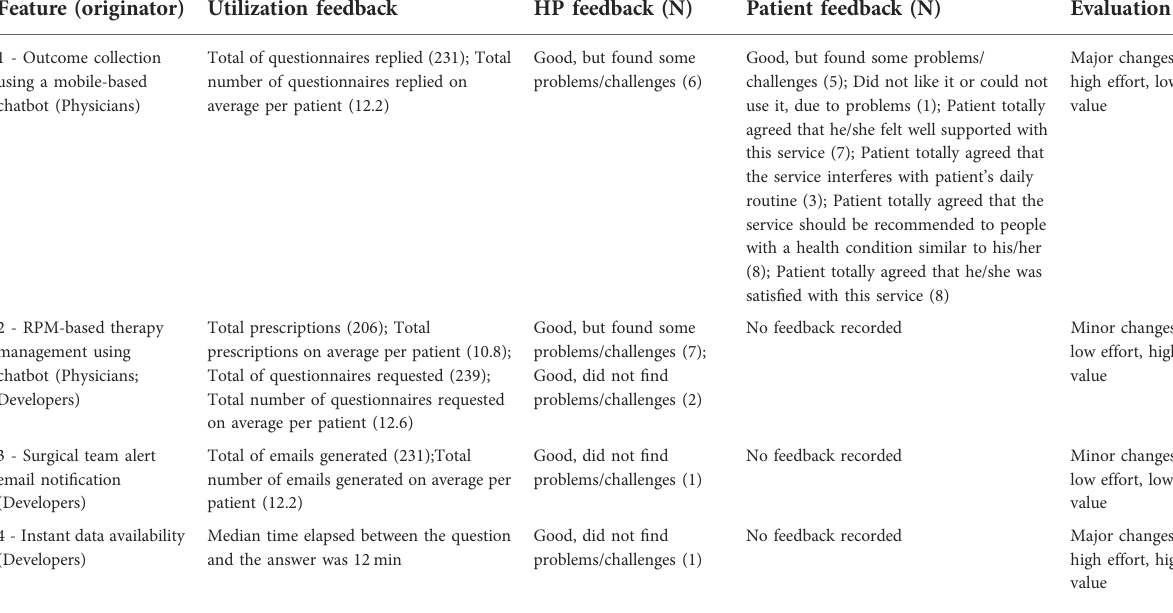
TABLE 4 List of features of pilot initiative 2. Feature (originator) Utilization